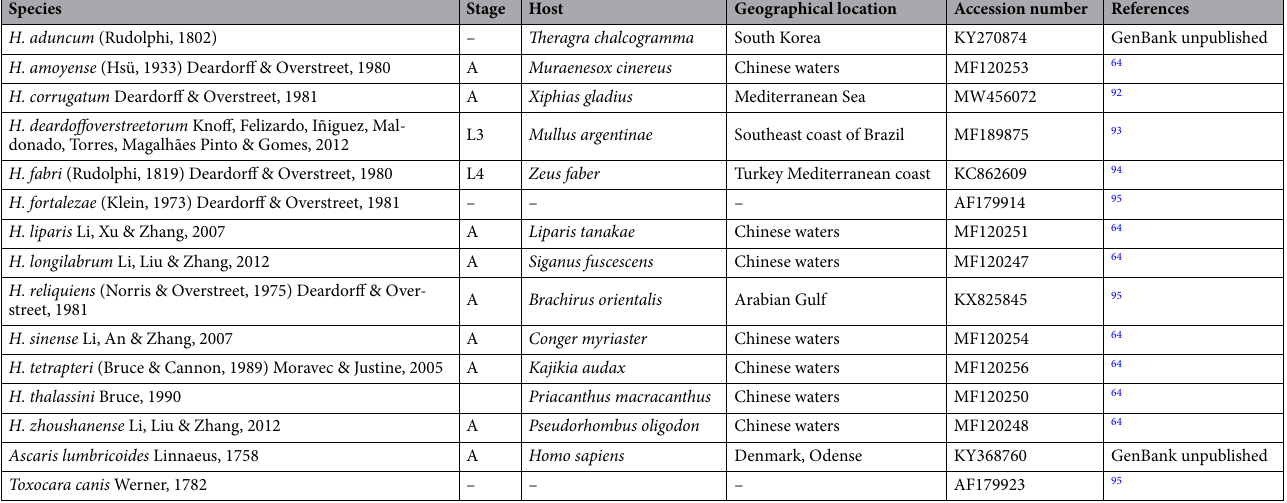
Table 2. Species, stage (A: adult, L4: fourth larval stage, L3: third larval stage), host, geographical location, and accession number of sequences of mtDNA cox 2 of Hysterothylacium species included in the Bayesian inference shown in Fig. 3. (–: data not